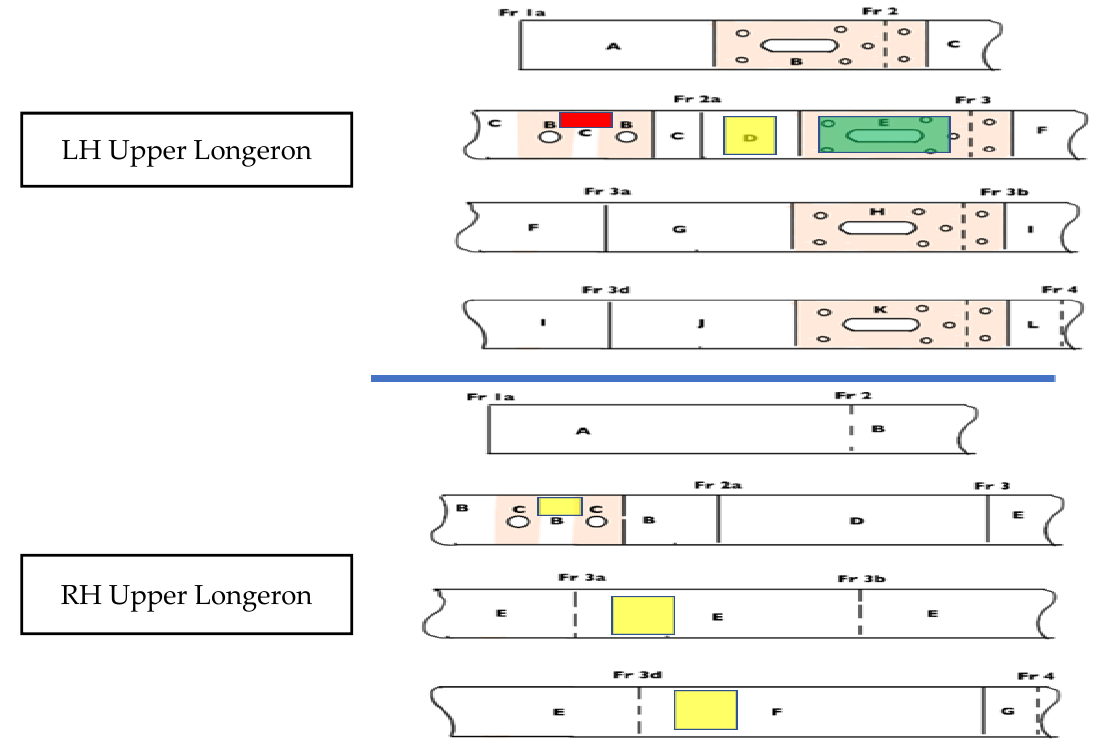
Figure 16. Inspection result for the RH and LH upper longeron.